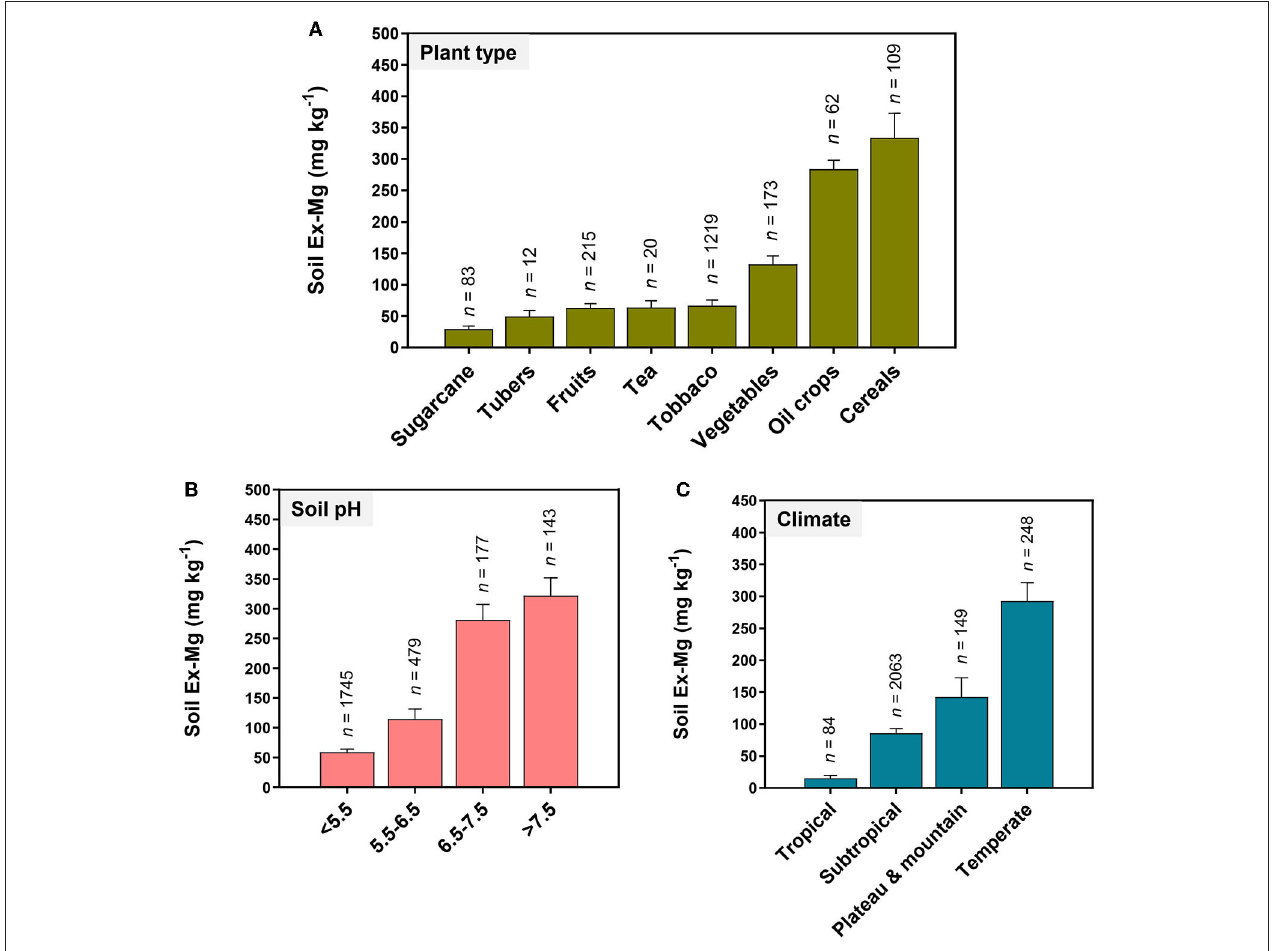
FIGURE 6 | Soil Ex-Mg variations with plant type, soil pH, and climate in China’s agricultural system. (A) Fruits, vegetables, sugarcane, tubers, tea, and tobacco contribute higher in the depletion of soil Ex-Mg. Mg deficiency becomes increasingly severe (B) in acidic soils, and (C) in tropical and subtropical climate zones of